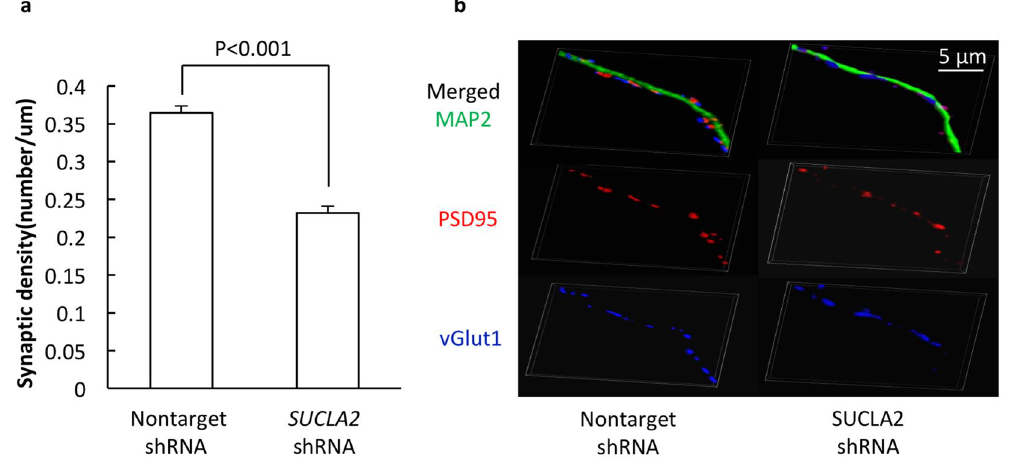
Figure 7. Loss of SCS A- β induces synaptic loss. ( a and b ) The co-staining of PSD95 (red) and vGlut1 (blue) Synapses were used to identify synapses. MAP2 (green) was used to determine the dendrites. SUCLA2- shRNA- treated neurons showed a significant decrease in their synaptic density. Data were collected from 27 neurons per group. Scale bar = 10 µ